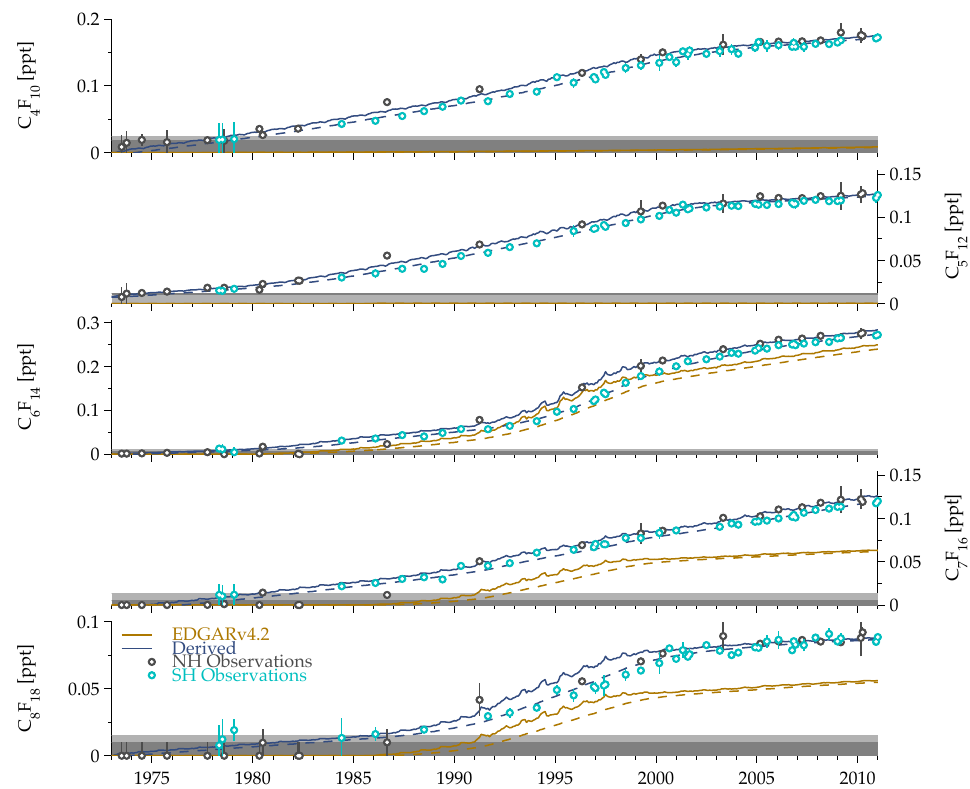
Fig. 1. MOZARTv4.5 model output at the observation grid cells (Northern Hemisphere – solid line and Southern Hemisphere – dashed line) for the reference run using emissions based on EDGARv4.2 (yellow lines) and the final derived emissions (blue lines). The open circles are the atmospheric observations (Northern Hemisphere – grey and Southern Hemisphere – light blue), with the vertical lines being the associated observational uncertainty. The detection limits for the instruments are shown as the grey shading, with dark grey for the SIO instrument and the light grey for the CSIRO